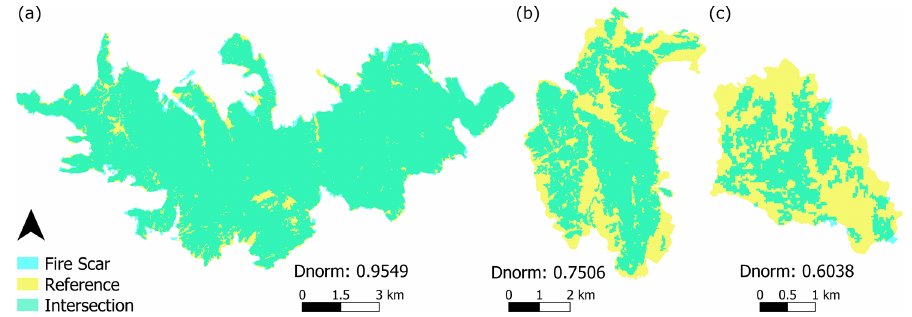
Figure 4. Evaluation of the fire scars. Shown are three examples comparing fire scars from CONAF with the images reconstructed using our Landscape Fire Scars Database methodology. See Sect. 2.3 for a detailed description of Dnorm.